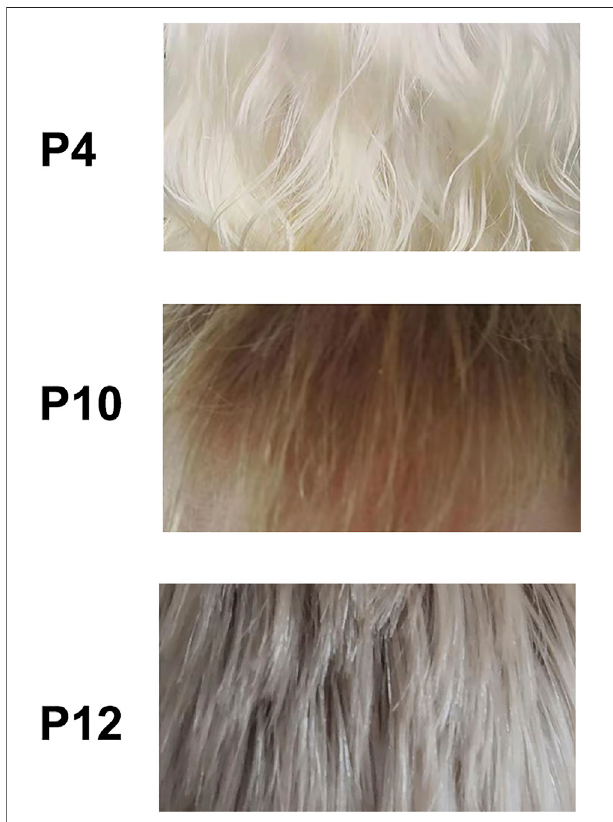
FIGURE 1 | Hair phenotype of OCA cases. p , patient. P4 had homozygous variant TYR : c.623T > G, p (Leu208Arg). P10 had compound variants TYR : c.929dupC, p (Arg311Lysfs*7) and TYR : c.1037 – 7A > T plus c.1037 – 10_11delTT. P12 had compound variants OCA2 : c.1325A > G, p (Asn442Ser) and OCA2 : c.2180T > C, p